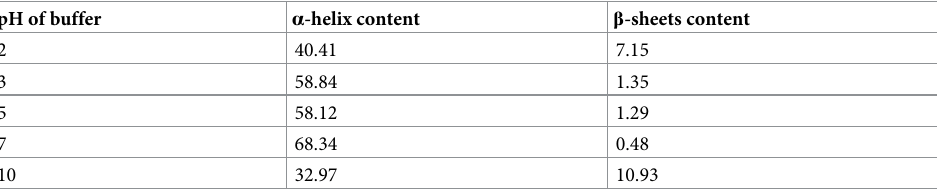
Table 1. Showing α helix and β -sheet content in recombinant Sus1 at different pH. Percentage of α -helix and β - sheet content was calculated using the MRE value at (190nm-240nm) using online software